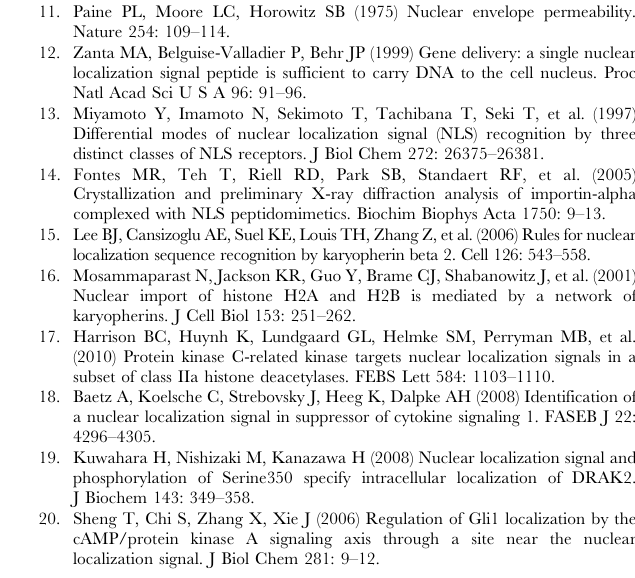
and casein kinase I (CKI) [25].